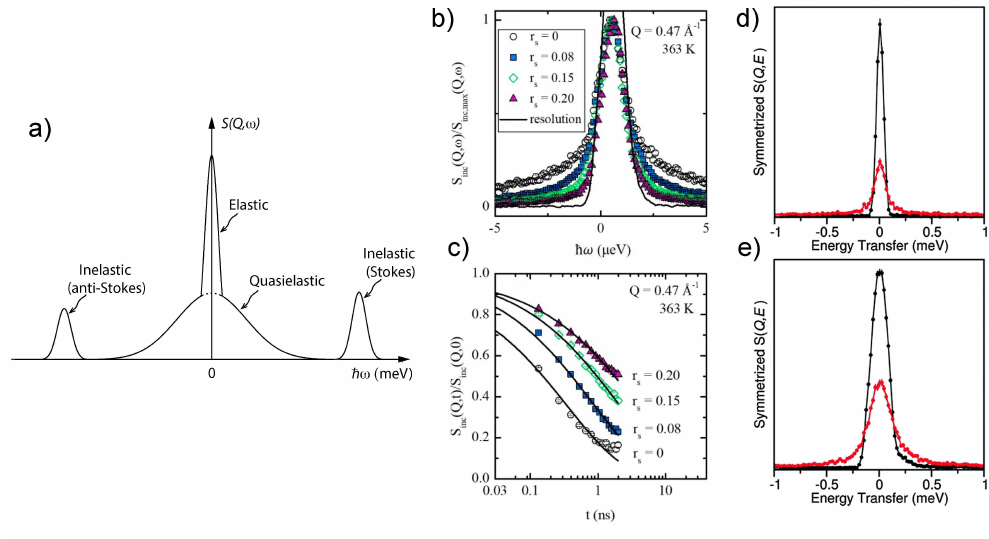
Figure 1. ( a ) Components of the QENS spectrum. Adapted with permission from reference